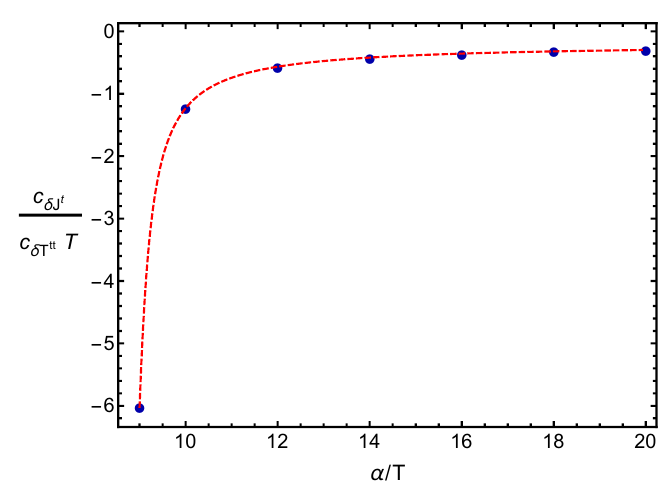
Figure 15 . The relative coefficient of δJ t to δT tt in the basis of the eigenvectors J ± in the incoherent limit (cf. eq. (C.5)). The blue points are numerically extracted by computing the coefficients in the basis of the eigenvectors of the data presented in the top right panel of figure 14. The red dashed line is the analytic result for δJ tt + γ t − ∼ δT − α δJ